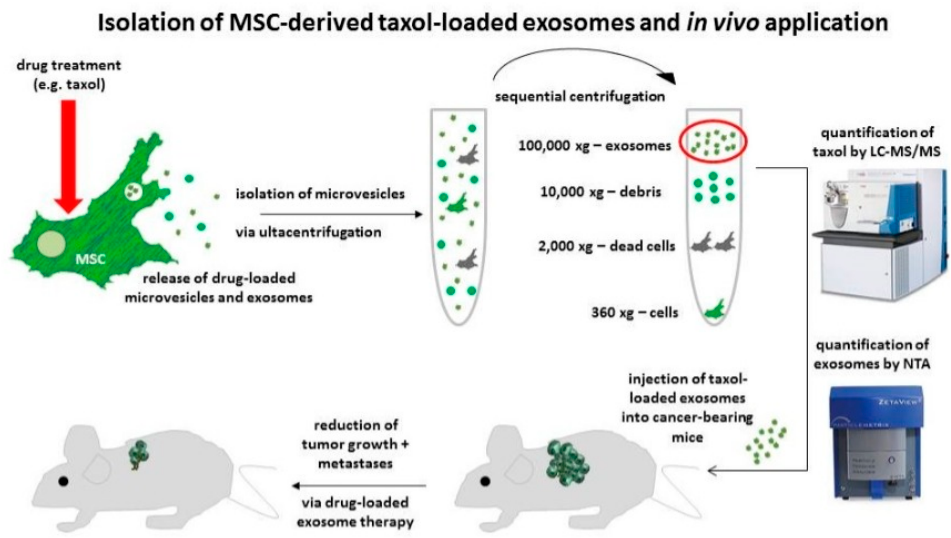
Figure 5. Schematic illustration of isolation of MSC-derived drug-loaded exosomes and efficacy eval- uation of targeting agent, in vitro as well as in vivo, to eradicate metastatic breast cancer. Reproduced with permission from ref. [110] Copyright © 2019, MDPI. Table 2. Recent examples of exosome-based drug delivery systems for breast cancer therapy. Vesicular